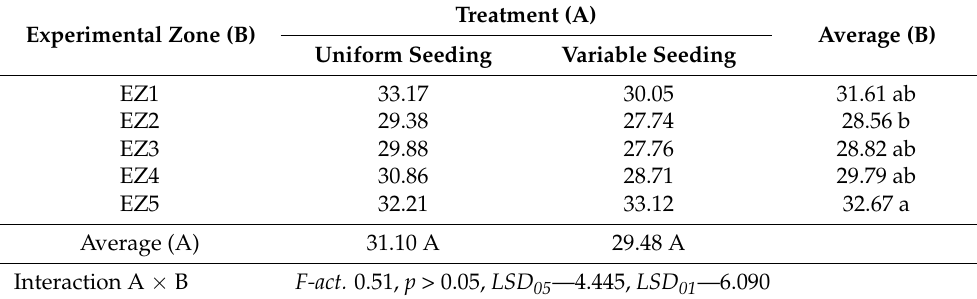
Table 5. Winter wheat seeding depth in different zones and seeding treatments of the experiment